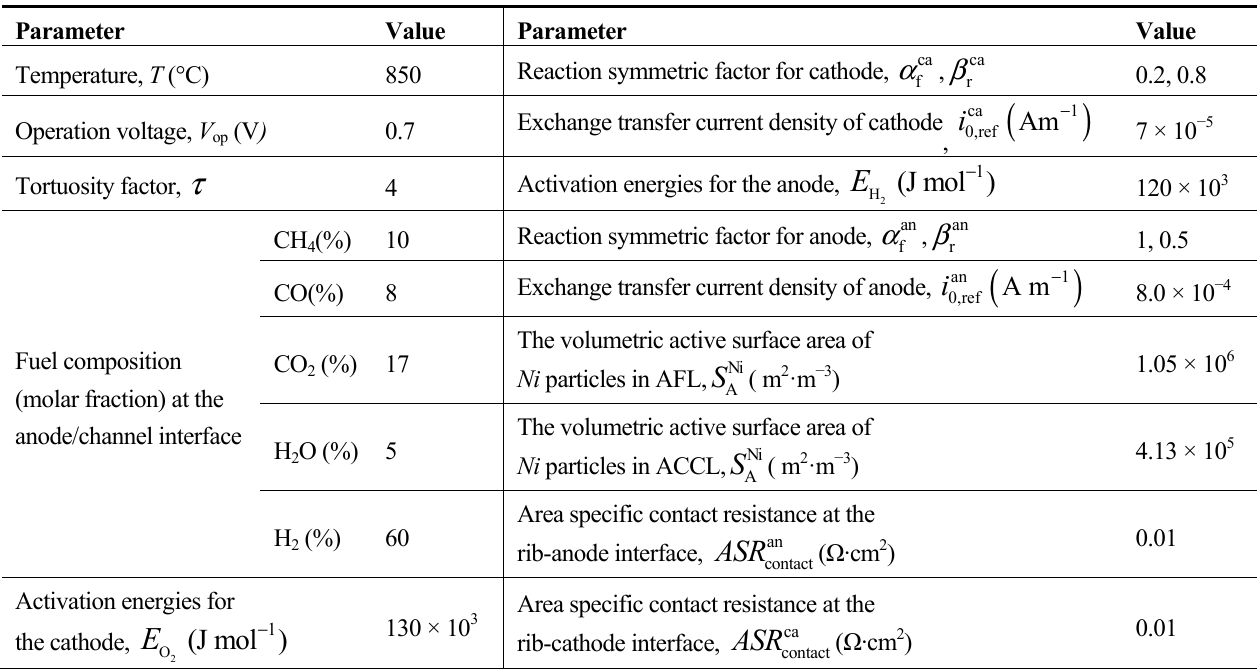
Table 3. Model parameters [44,45].